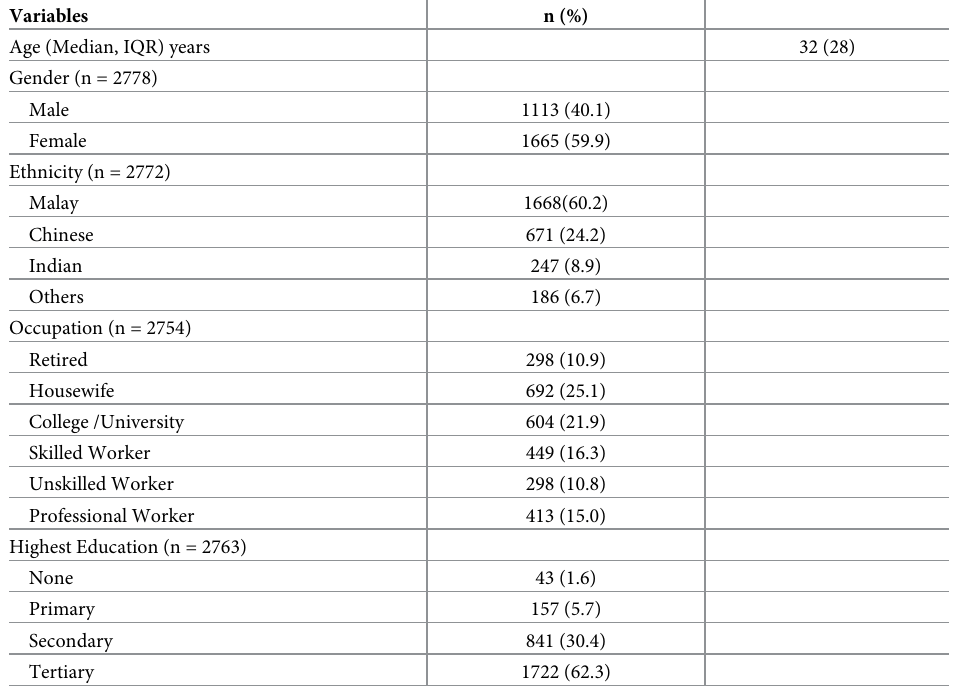
Table 1. Sociodemographic characteristics of the study participants (n =